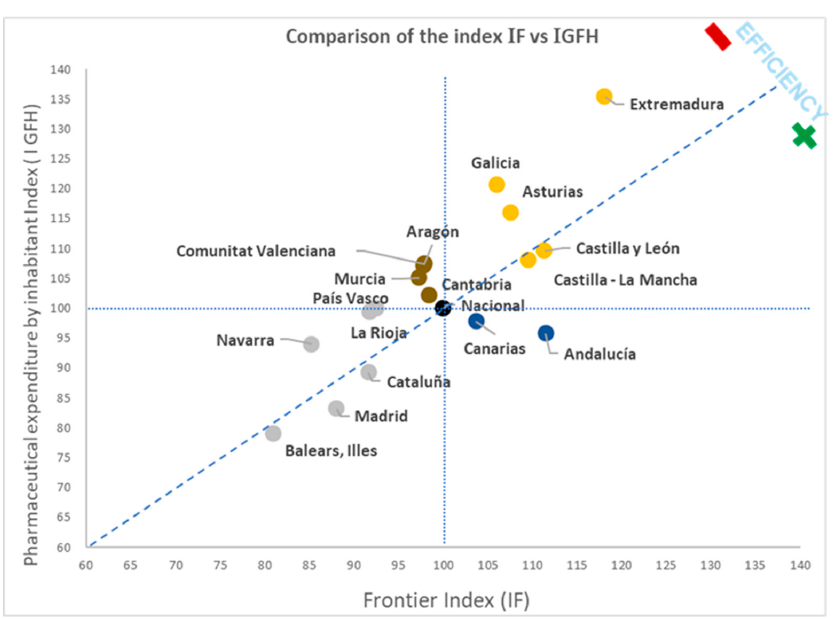
Figure A1. Comparison of the index IF vs. IGFH.